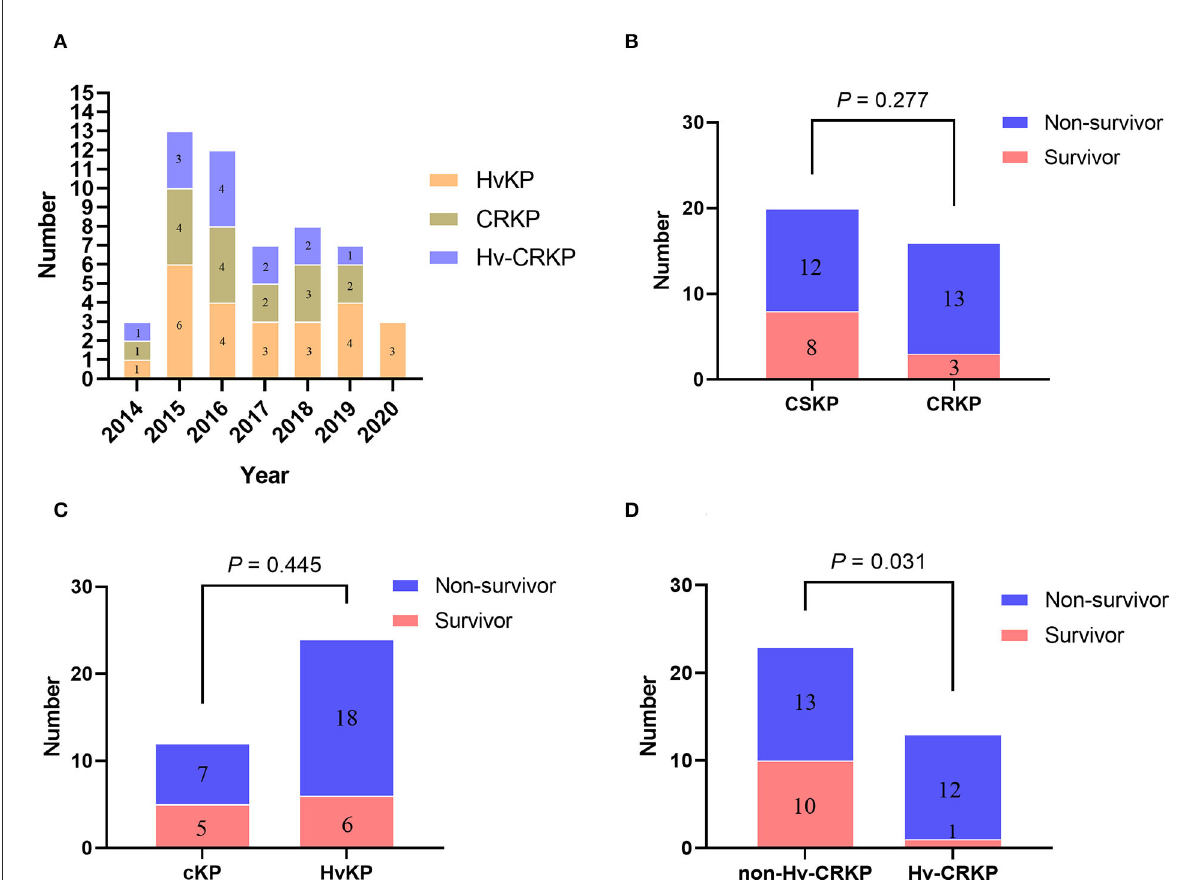
FIGURE2 Time distribution and survival rate characteristics of the strains. (A) The number of specific strains detected in each year; (B) Comparison of mortality between patients infected with CSKP and CRKP; (C) Comparison of mortality between patients infected with cKP and HvKP; (D) Comparison of mortality between patients infected with non-Hv-CRKP and